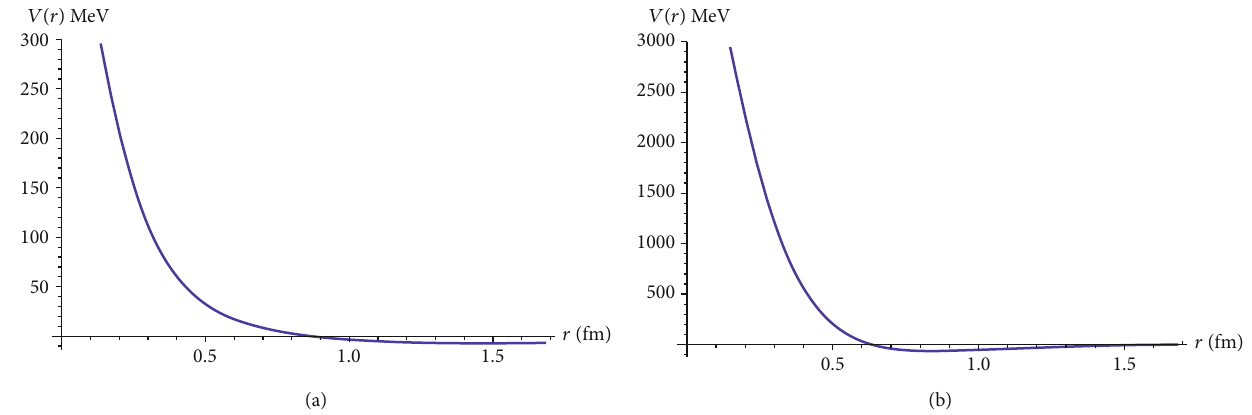
Figure 4: The potential with GY and SPED functions, respectively, of 4 He nuclei as OBEP through the exchange of σ and ω mesons, with parameter II.